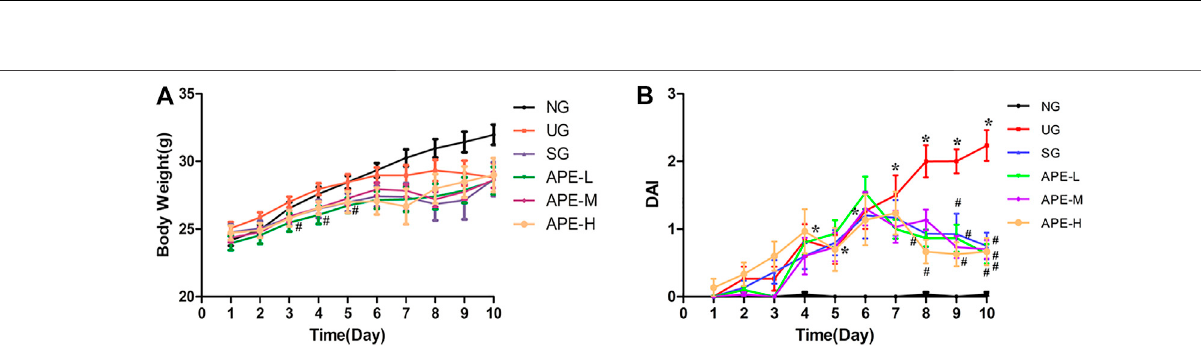
Frontiers in Pharmacology |